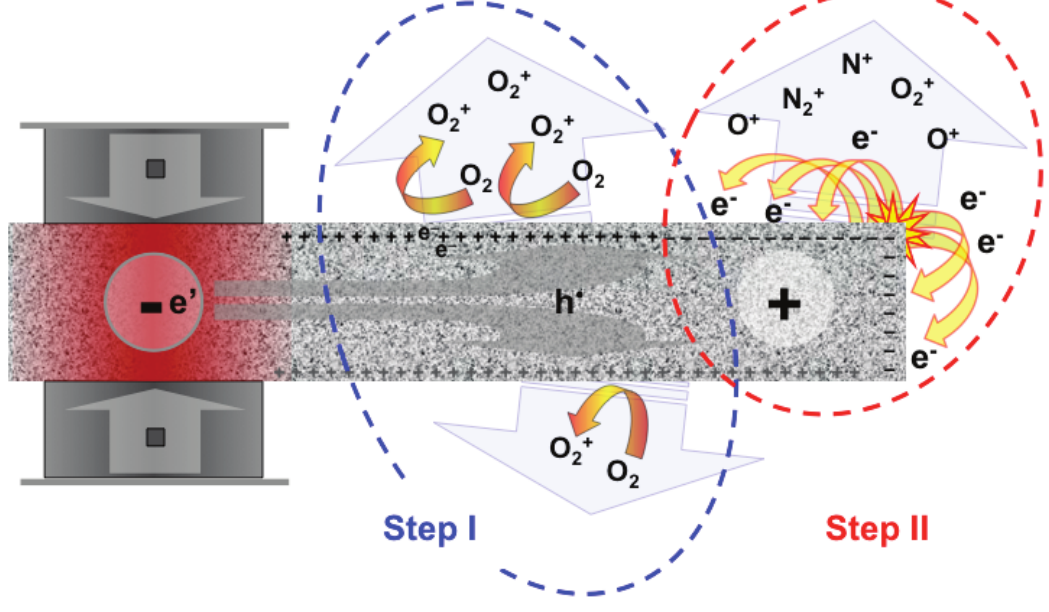
Figure 5. Schematic representation of the 2-step air ionization that has been demonstrated in laboratory experiments during stressing of rocks